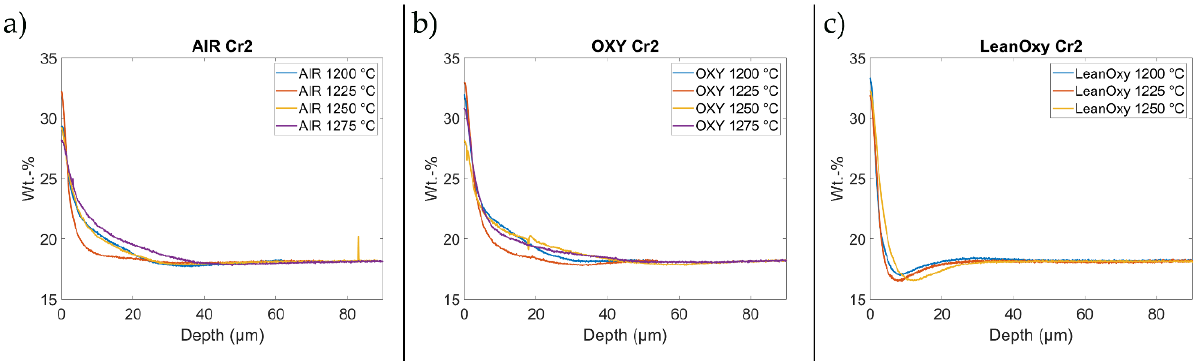
Figure 10. The individual temperature GDOES graphs for Cr in ( a ) air, ( b ) oxyfuel and ( c ) lean oxyfuel atmosphere.